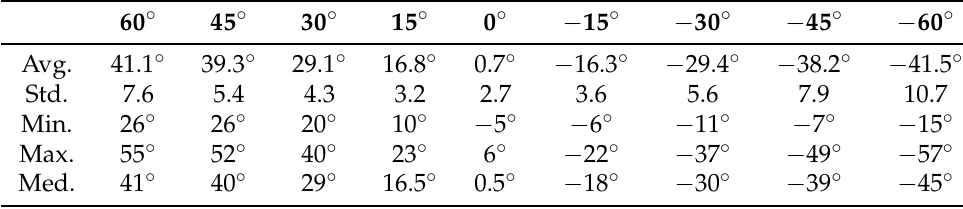
Table 3. The yaw values estimated from our rotated face images.